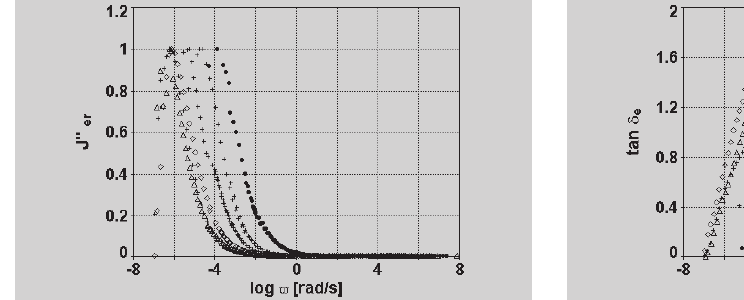
Figure 8 (left): Relative modified loss com- pliance (T r = 0°C: • Base, + 1%, 2%, 4%, SBSr (from right to left), (cid:3)(cid:3) 6% SBSr, ◊ 8% SBSr). Figure 9: Modified loss tangent (T r = 0°C: • Base, + 8% SBSr, (cid:3)(cid:3) 4% SBS l, ◊ 4% SBSr, •+• 4%